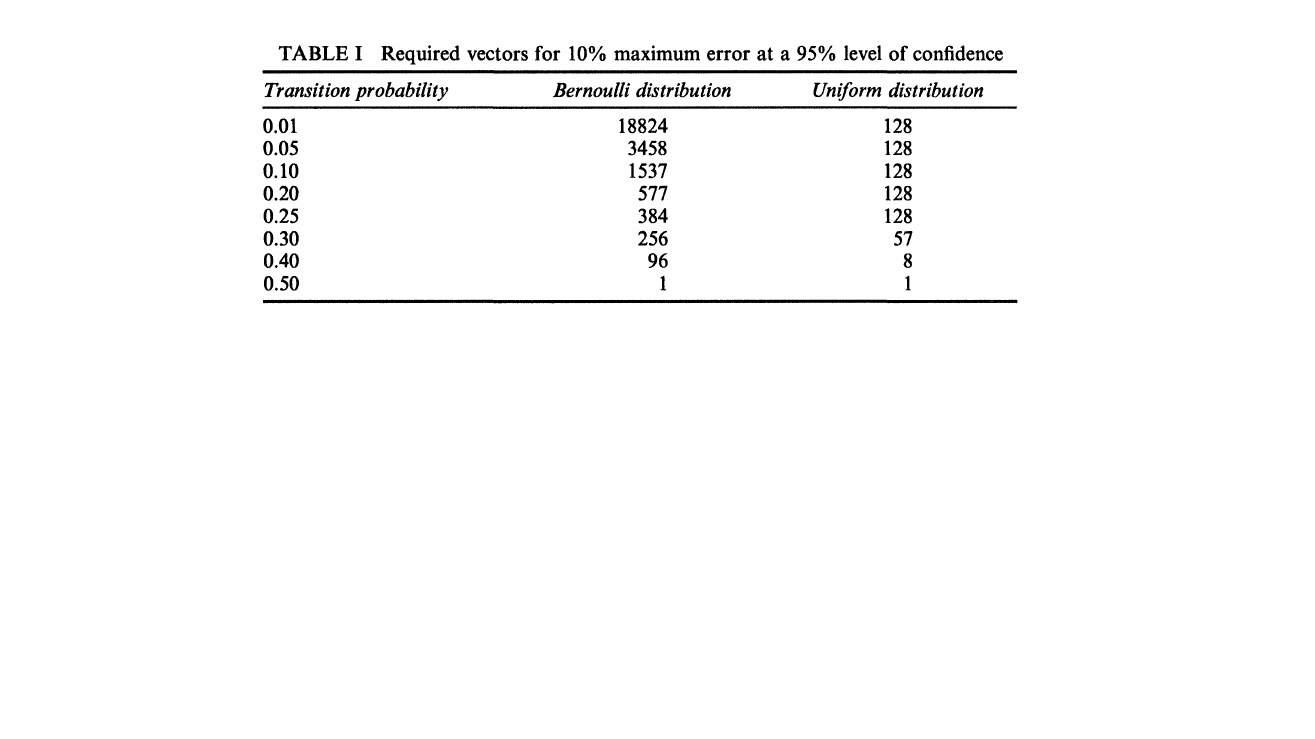
Required vectors for 10% maximum error at a 95% level of confidence Transition probability Bernoulli distribution Uniform